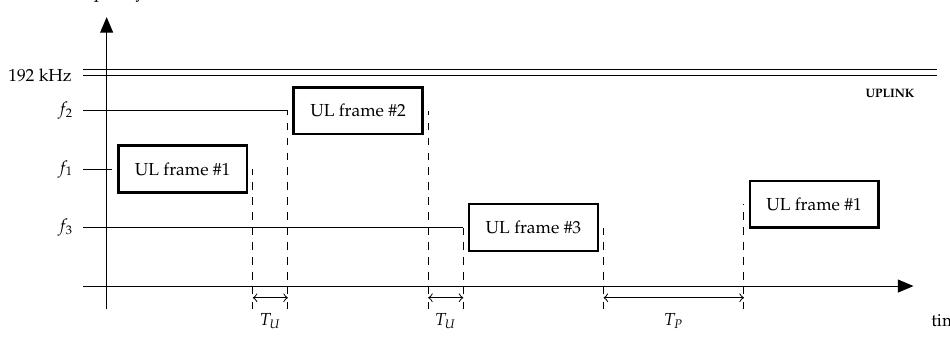
Figure 8. Multiple frames U-procedure in